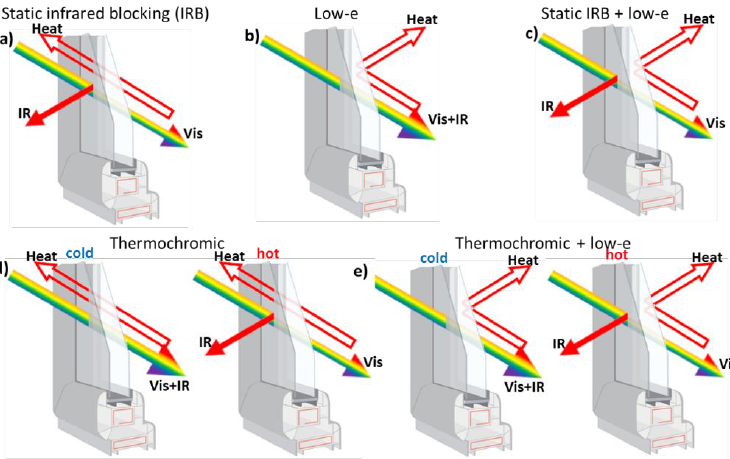
Figure 1. Schematic depiction of transmission / blocking of visible and infrared solar radiation and radiator heat of ( a ) static IRB glazing, ( b ) low-e glazing, ( c ) combined static IRB / low-e glazing, ( d ) thermochromic glazing and ( e ) combined thermochromic / low-e glazing.